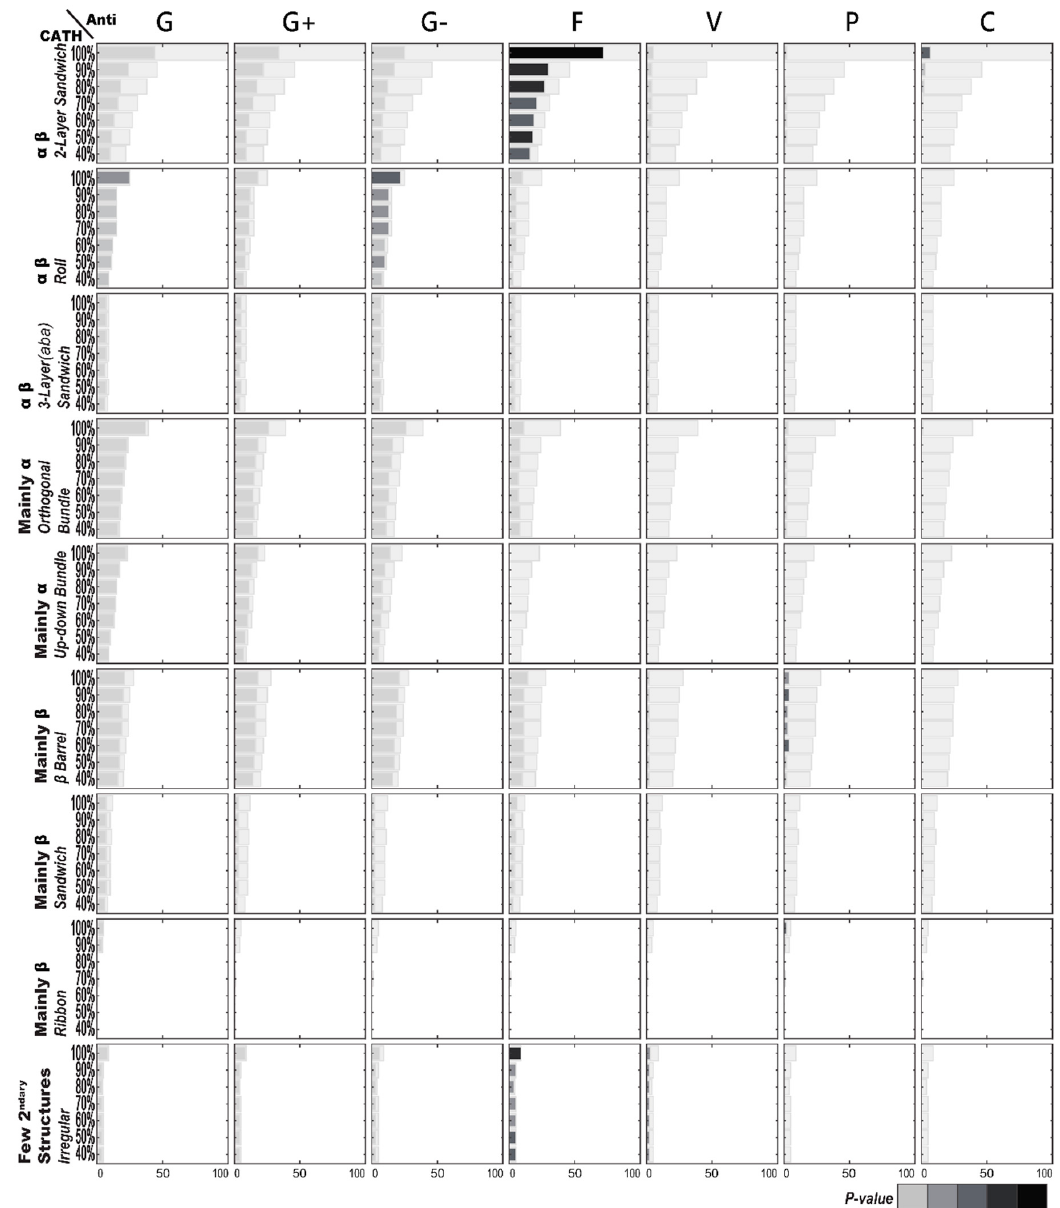
Figure 1. Antimicrobial peptide (AMP) functional enrichment analysis with respect to CATH structures. The X -axis and Y -axis are, respectively, the number of AMP sequences and the percentage of sequence identity. The bar in light gray indicates the potential maximum number of AMP sequences with the specific function. Abbreviations: C, anticancer; F, antifungal; G, antibacterial; G+, anti-Gram+; G-, anti-Gram-; P, antiparasitic; V, antiviral.